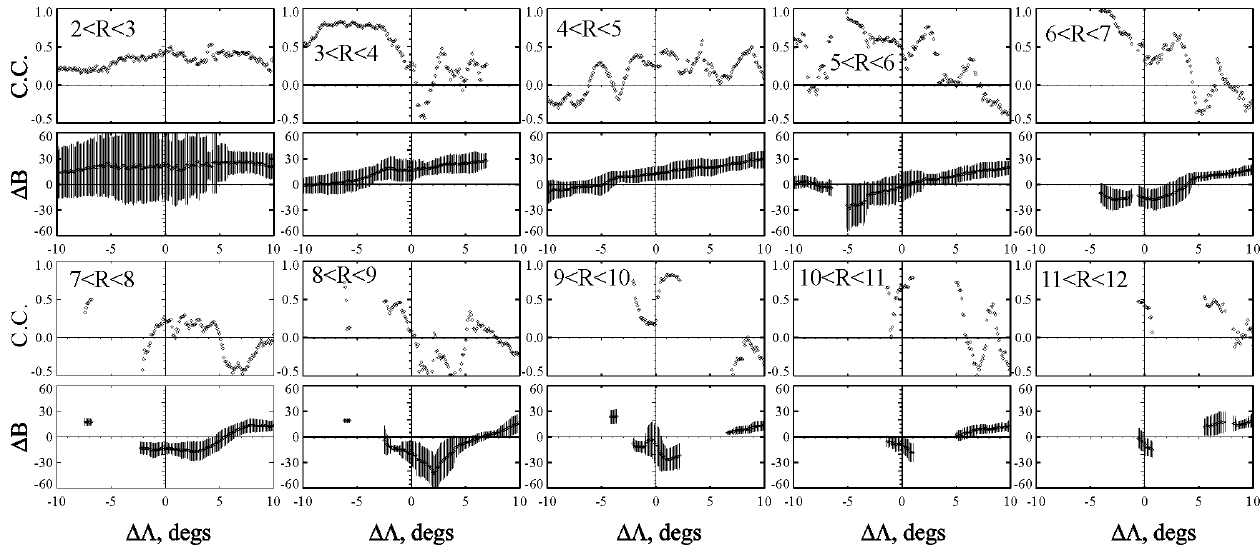
Fig. 7. Same as in Fig. 6, but for the minimal exposure of the polar cusps to the incoming solar wind: 9 ≤− 15 ◦ and 9 ≥+ 15 ◦ for the northern and southern polar cusps, respectively. (The “wintertime” case